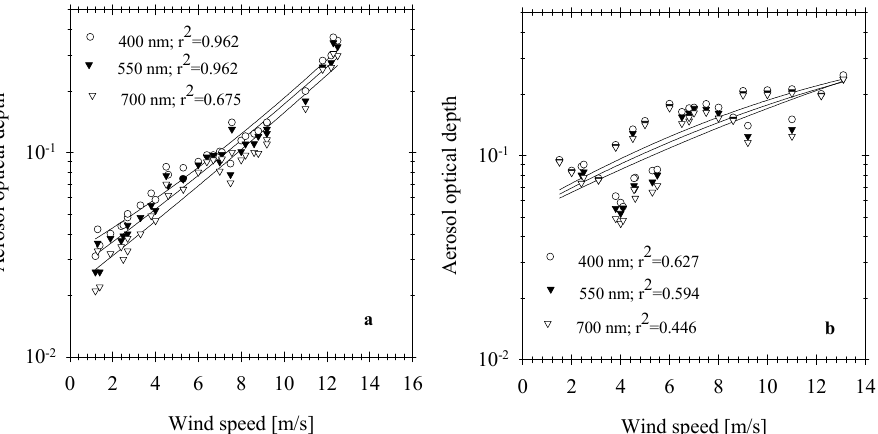
Figure 4. Variations of aerosol optical depth on wind speed at a coastal station of Lubiatowo for onshore (a) and offshore winds